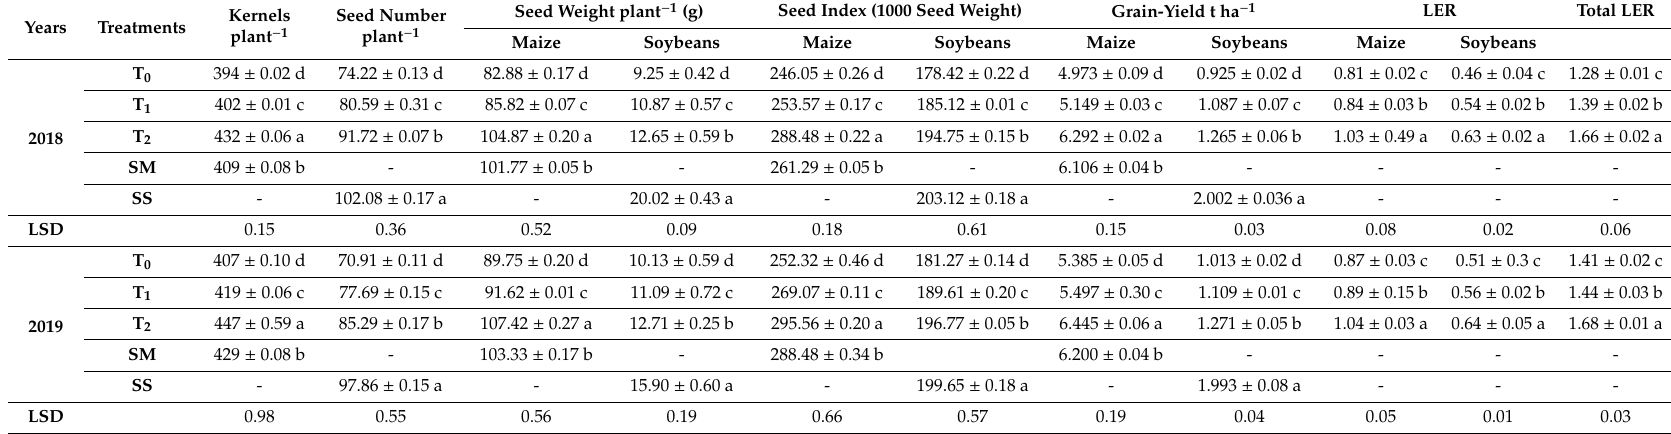
Table 2. E ff ect of di ff erent potassium application on yield and yield-related components of maize and soybean intercropping and sole cropping during